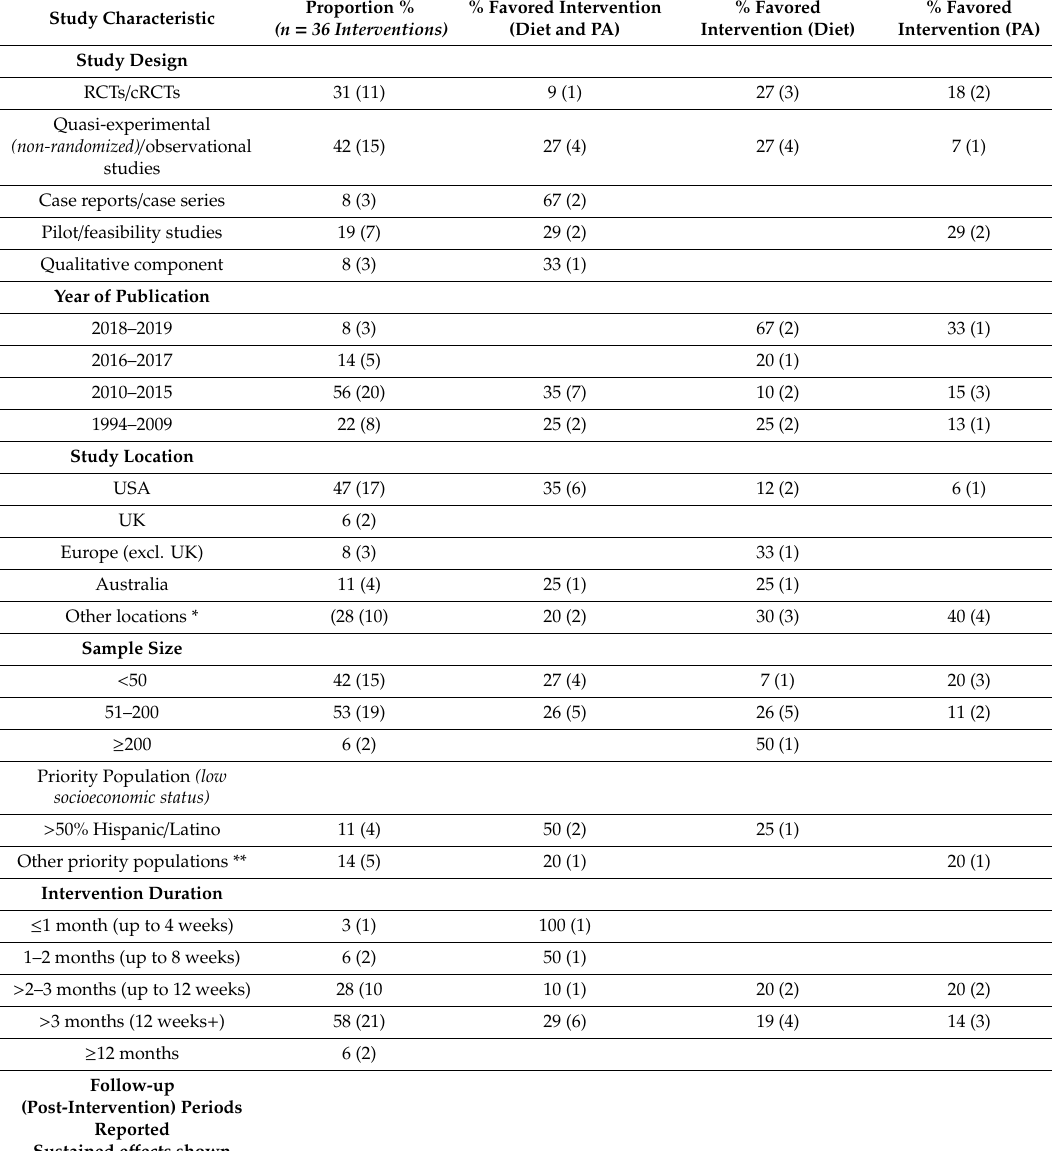
Table 2. Characteristics of 36 interventions included in systematic review of family-based weight-management programs with diet and physical activity behavioral